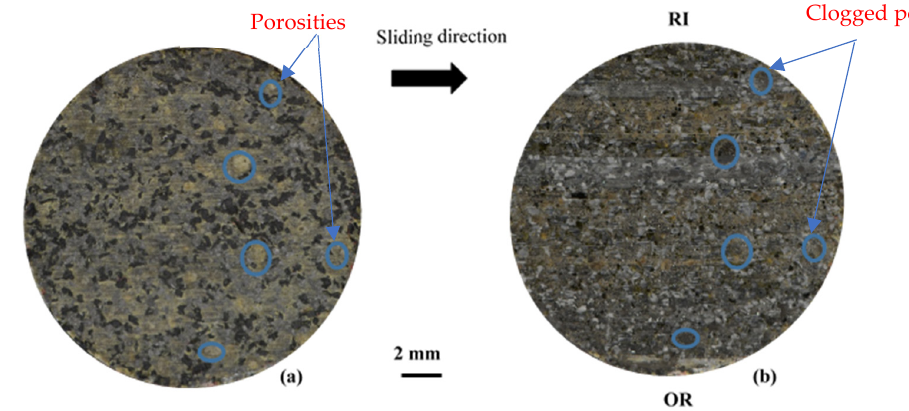
Figure 12. Photos taken before ( a ) and ( b ) after the friction tests for FMFBs. The areas corresponding to the stripes (Figure 6b) have an open contact at the IR and towards the AR. They consist of accumulated third-body particles (in light grey), which are free to flow and do not form load-bearing plateaus (Figures 13 and 14).